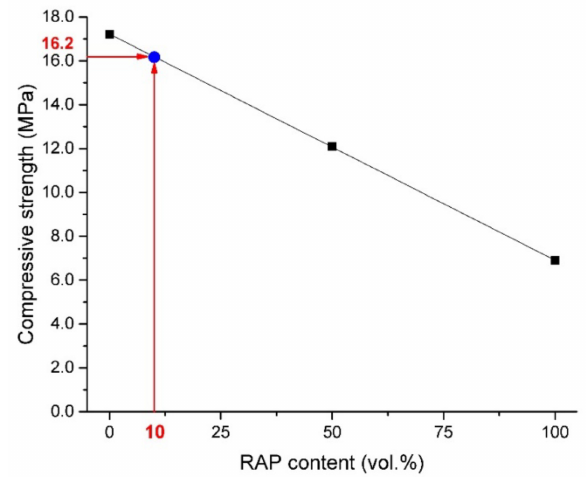
Figure 4. Comparison of compressive strengths obtained on cylindrical samples of concretes with a di ff erent content of the RAP aggregate.